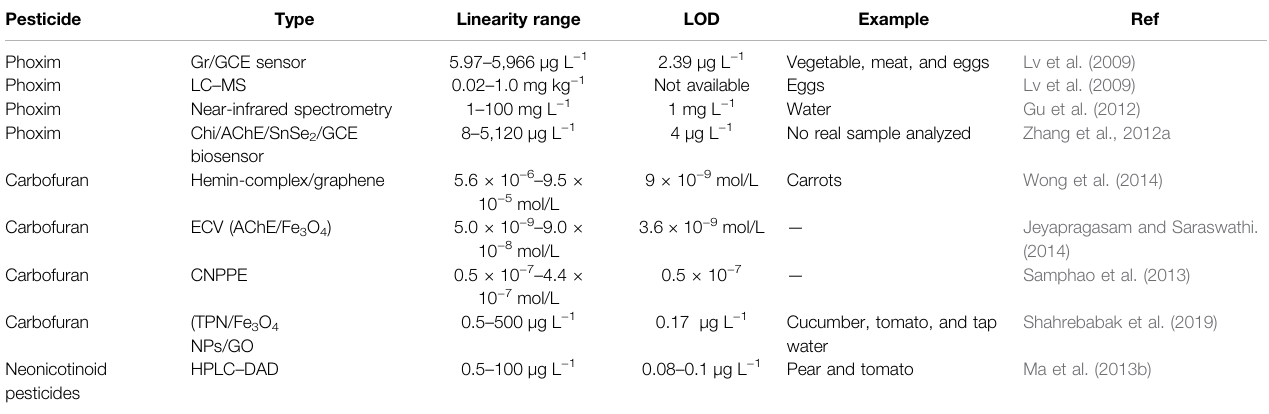
TABLE 2 | Applications of graphene in detecting